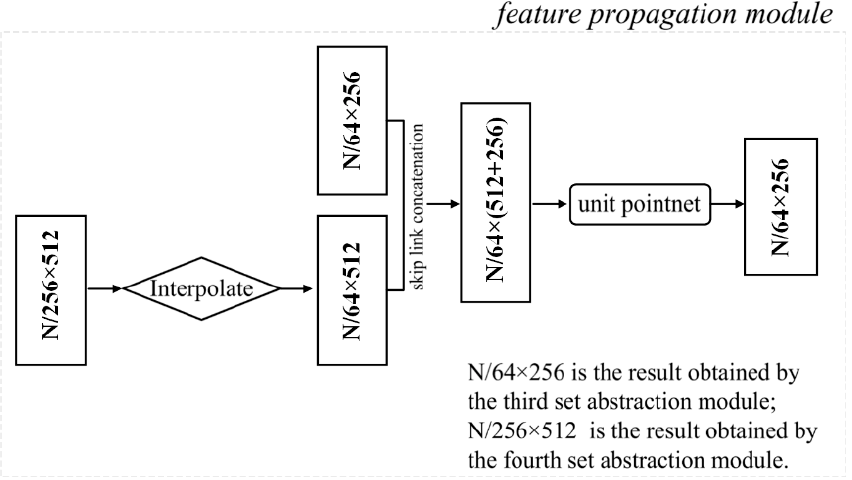
Figure 6. An illustration of the feature propagation module.